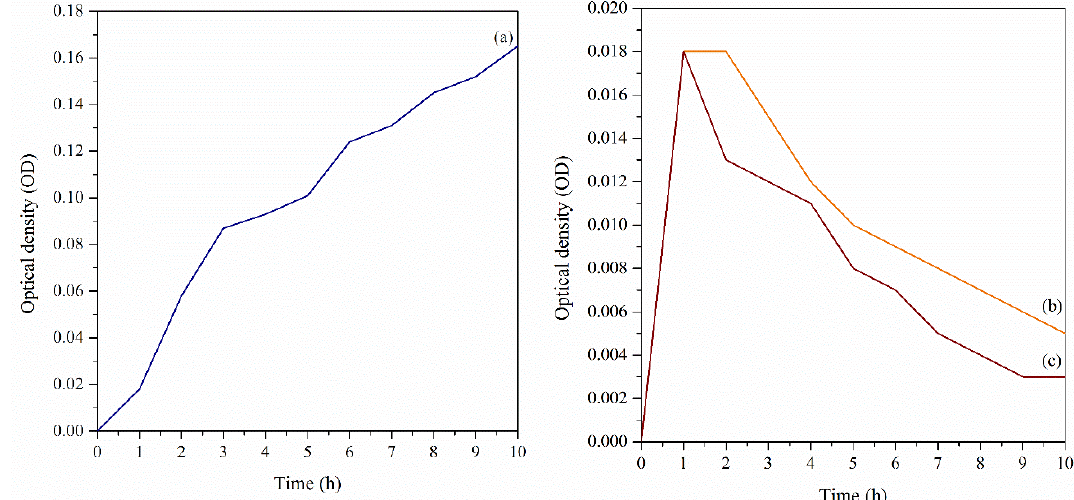
Figure 8. ( a ) The growth profile of E. coli culture without further addition and further addition of ( b ) GG-Carv 08 and ( c ) Carv 0.08 M, after 16 h incubation of E. coli culture.